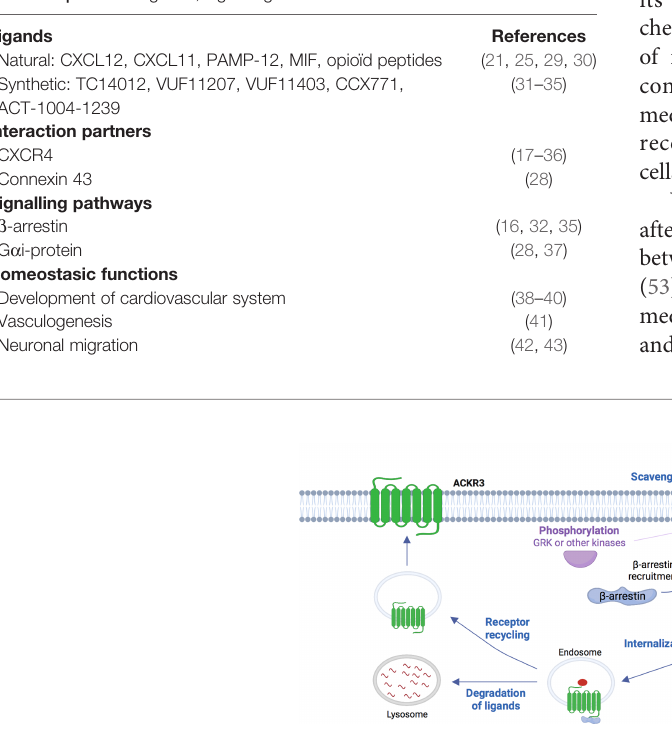
FIGURE 1 | Schematic representation of signaling pathways for ACKR3. Chemokines ligands CXCL12 and CXCL11 can induce phosphorylation of ACKR3 by GRK or others kinases, the recruitment of b -arrestins and trigger intracellular G-protein independent signaling. ACKR3 is also able to scavenge various ligands (CXCL12, CXCL11, ADM, PAMP, PAMP12, opio ї d peptides) at the cell surface, internalized these ligands which subsequently result in degradation in lysosome while the receptor recycles to the cell membrame. ACKR3 is also able to interact with G-proteins without to lead to their activation. However, in two speci fi c cellular types, primary rodent astrocytes and human glioma cells, ACKR3 can be coupled to G a -protein and triggers PLC and MAPK activation. GRK, G-protein receptor kinase; ADM, adrenomedullin; PAMP, proadrenomedullinN-terminal 20 peptide; PLC, phospholipase C; MAPK, mitogen-activated protein kinase. (Figure created with